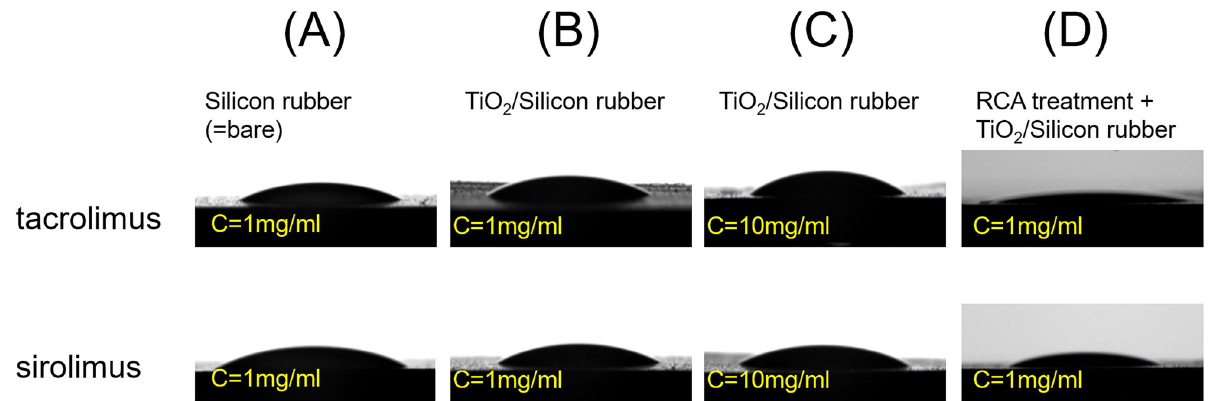
Fig 2. Contact angles of dissolved drugs on the silicon plate with different drug concentrations and coating methods. Larger contact angles of dissolved drugs indicate greater thickness of the drugs and vice versa. (B and C) When the concentration of the drug increased, the contact angle increased. (D) The contact angle on the silicon rubber with TiO 2 thin film after RCA treatment was the smallest among all types of silicon rubber. The thin coating was caused by its hydrophilic property. C =